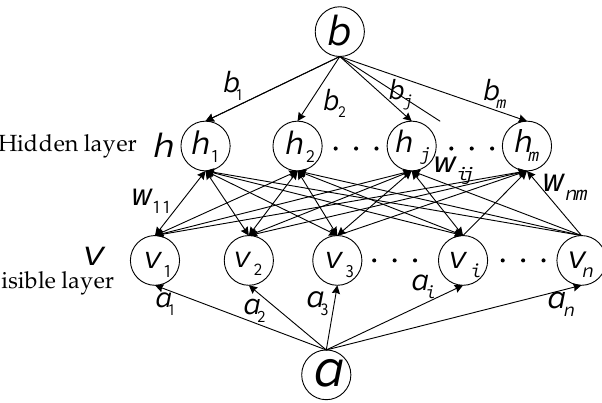
Figure 1. Architecture of a Restricted Boltzmann Machine (RBM).